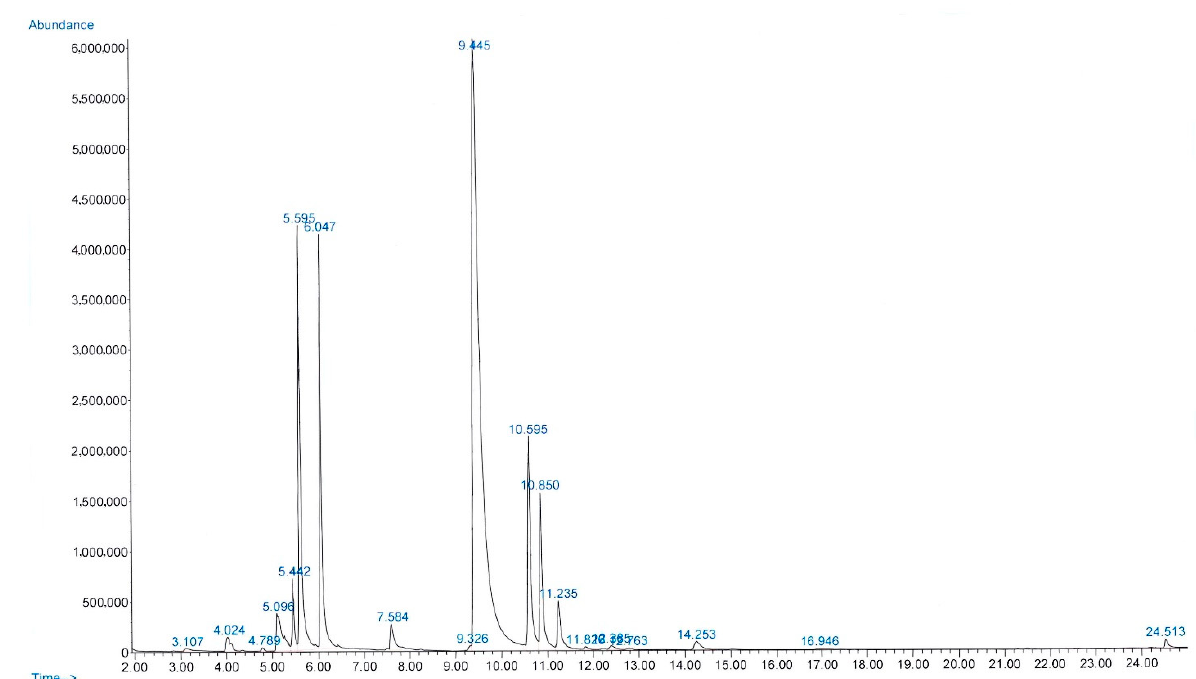
Figure 1. Chromatogram of the main components of Coleus amboinicus essential oil, as determined via gas chromatography–mass spectrometry. Table 1. Chemical composition of Coleus amboinicus essential oil.